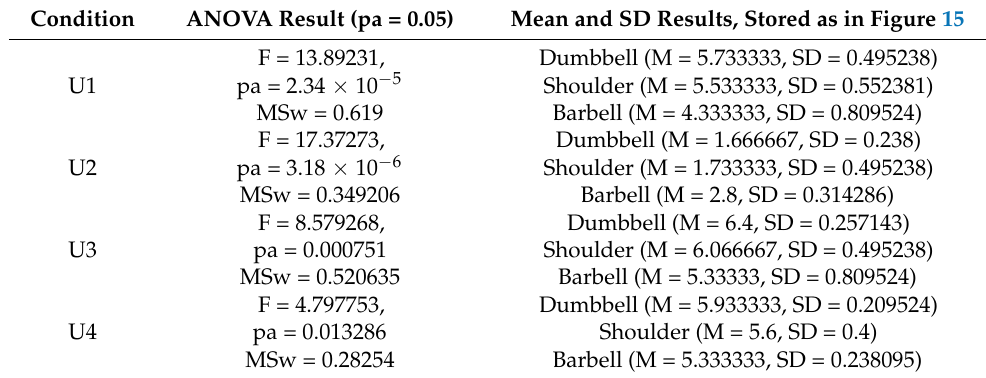
Table 10. Results of the ANOVA test on the interaction in Experiment 2.